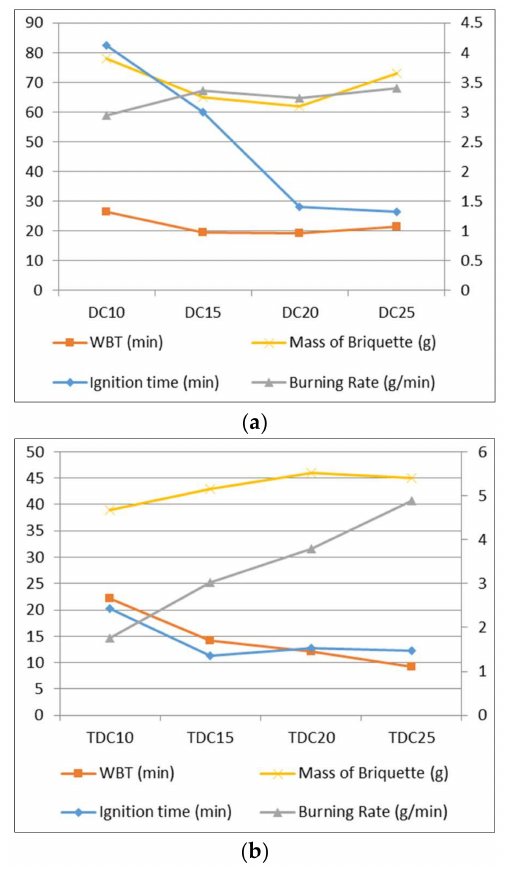
Figure 6. Thermal characteristics of ( a ) sun-dried and ( b ) torrefied carrot